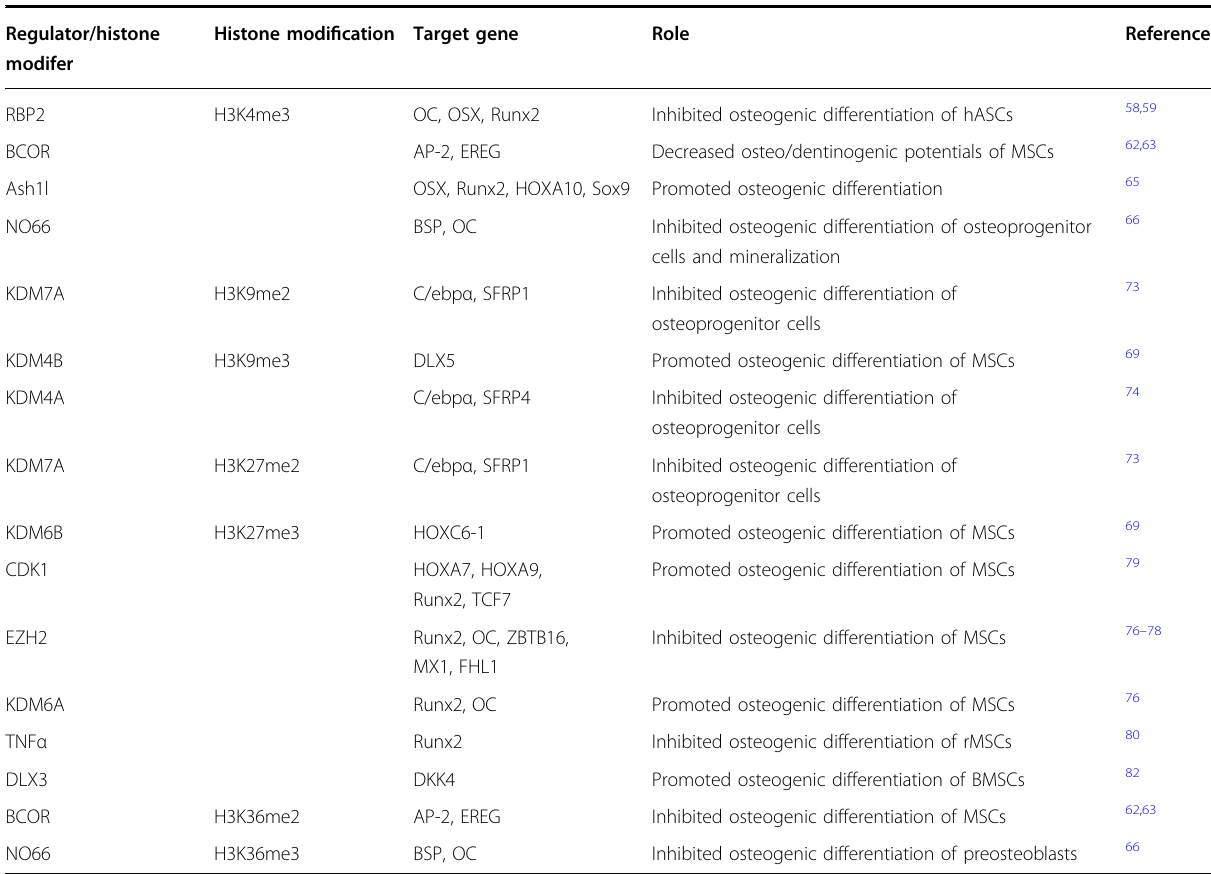
Table 2 Histone methylation centric-regulation in osteogenic genes expression.